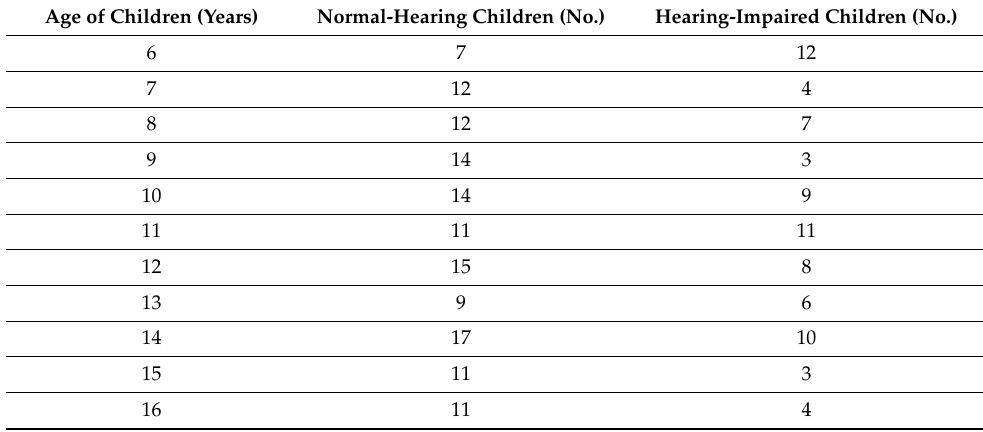
Table 1. Normal hearing and hearing impaired children per